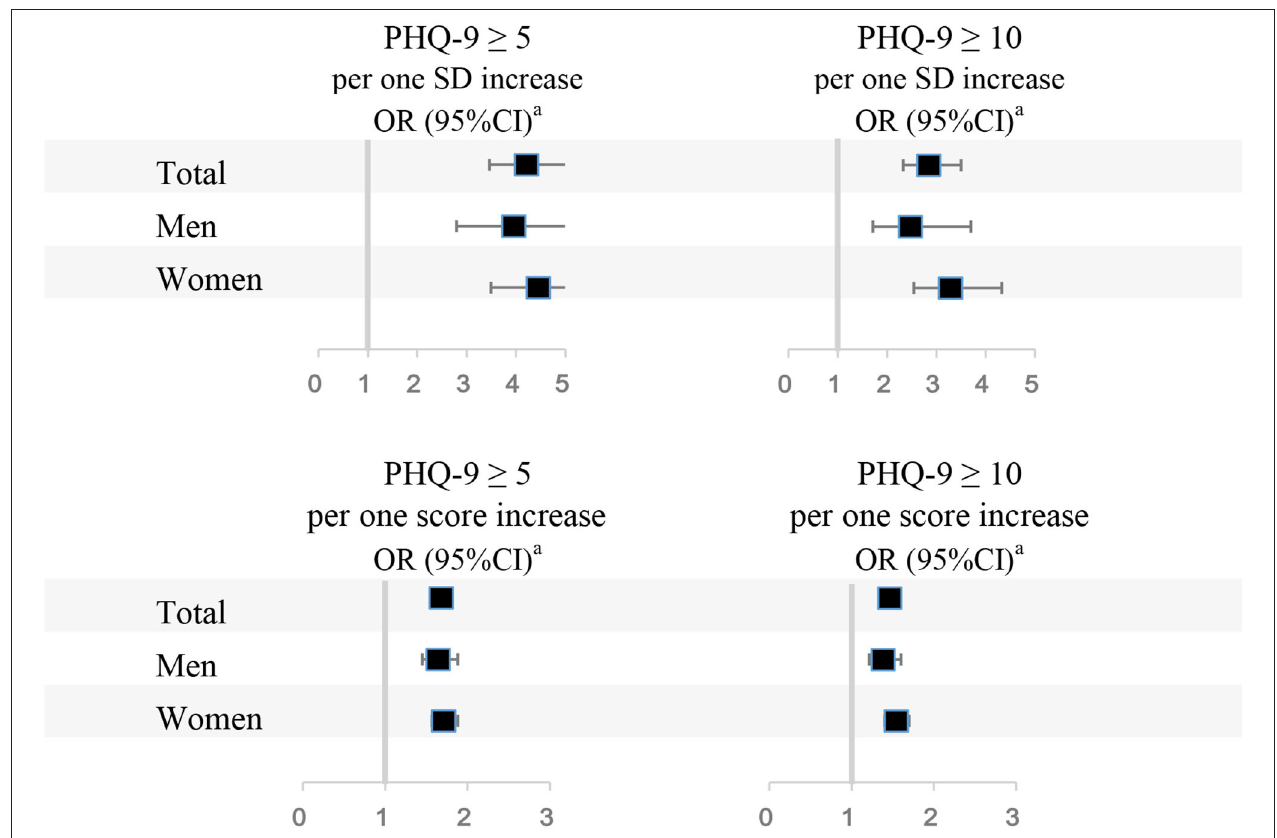
FIGURE 1 | Associations between PSQI scores and depressive symptoms. PSQI, Pittsburgh Sleep Quality Index; PHQ-9, Patient Health Questionnaire-9; OR 95% CI, Odds ratio (95% confidence interval). a Adjusted for age, body mass index, sex (if appropriate), physical activity, household income, working time, night shifts, visiting friends constantly, religious or not, marital status, siblings or not, experienced a major life event or not, current year of residency, smoking status, alcohol consumption, coffee intake, and